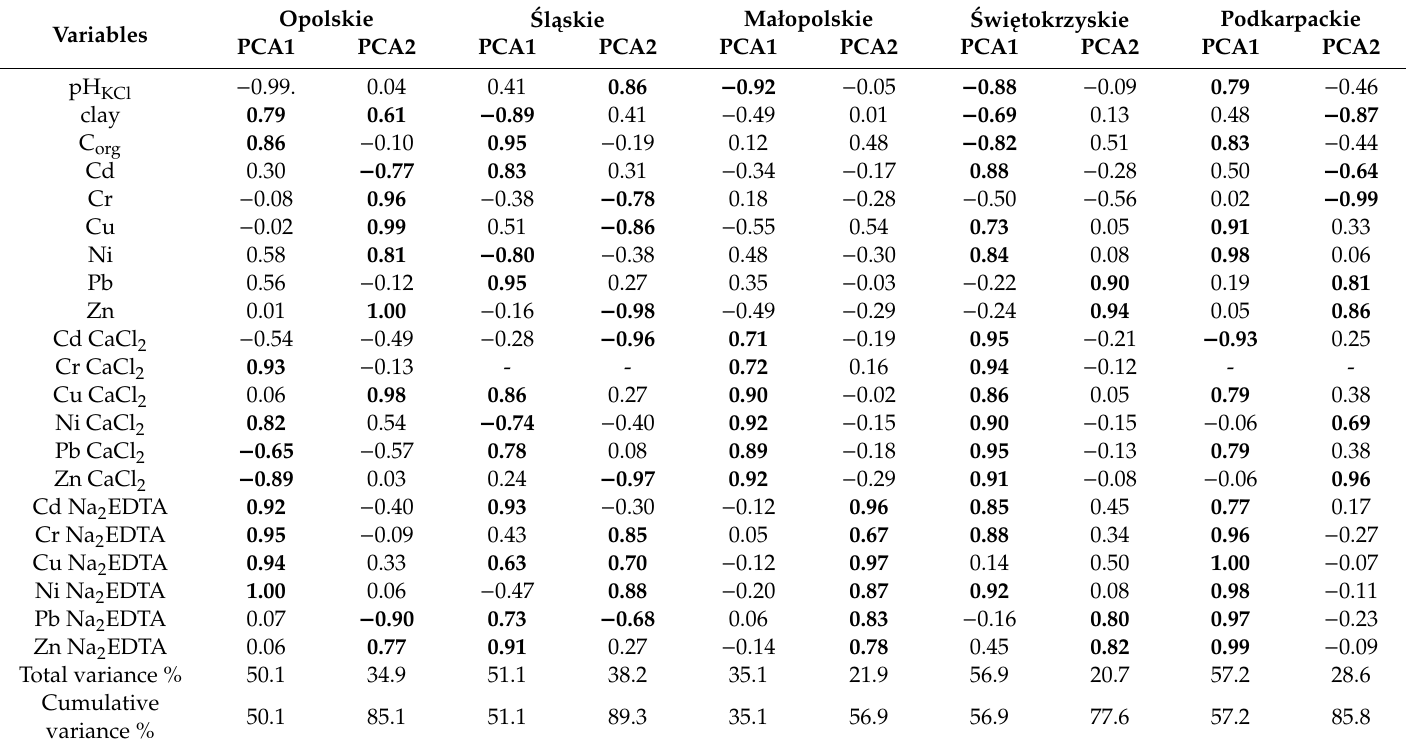
Table 4. Component matrix of variables ( n =